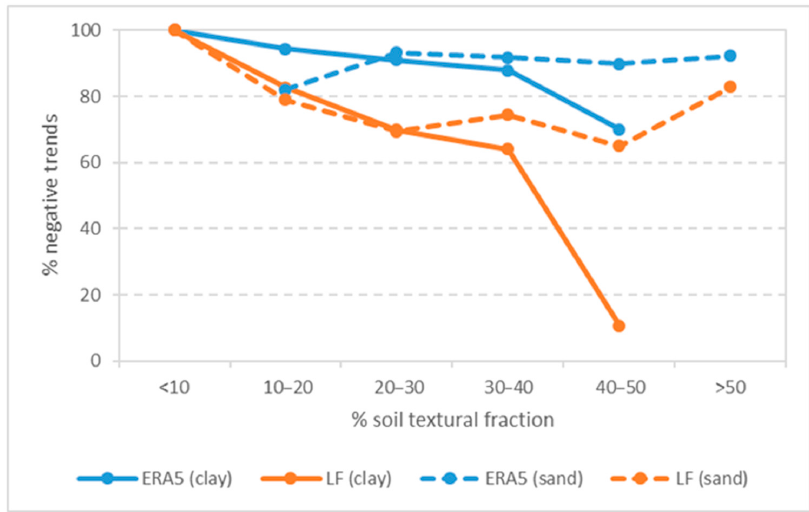
Figure 6. Relationship between the negative trends percentage (anomalies) and soil textural fraction percentage.